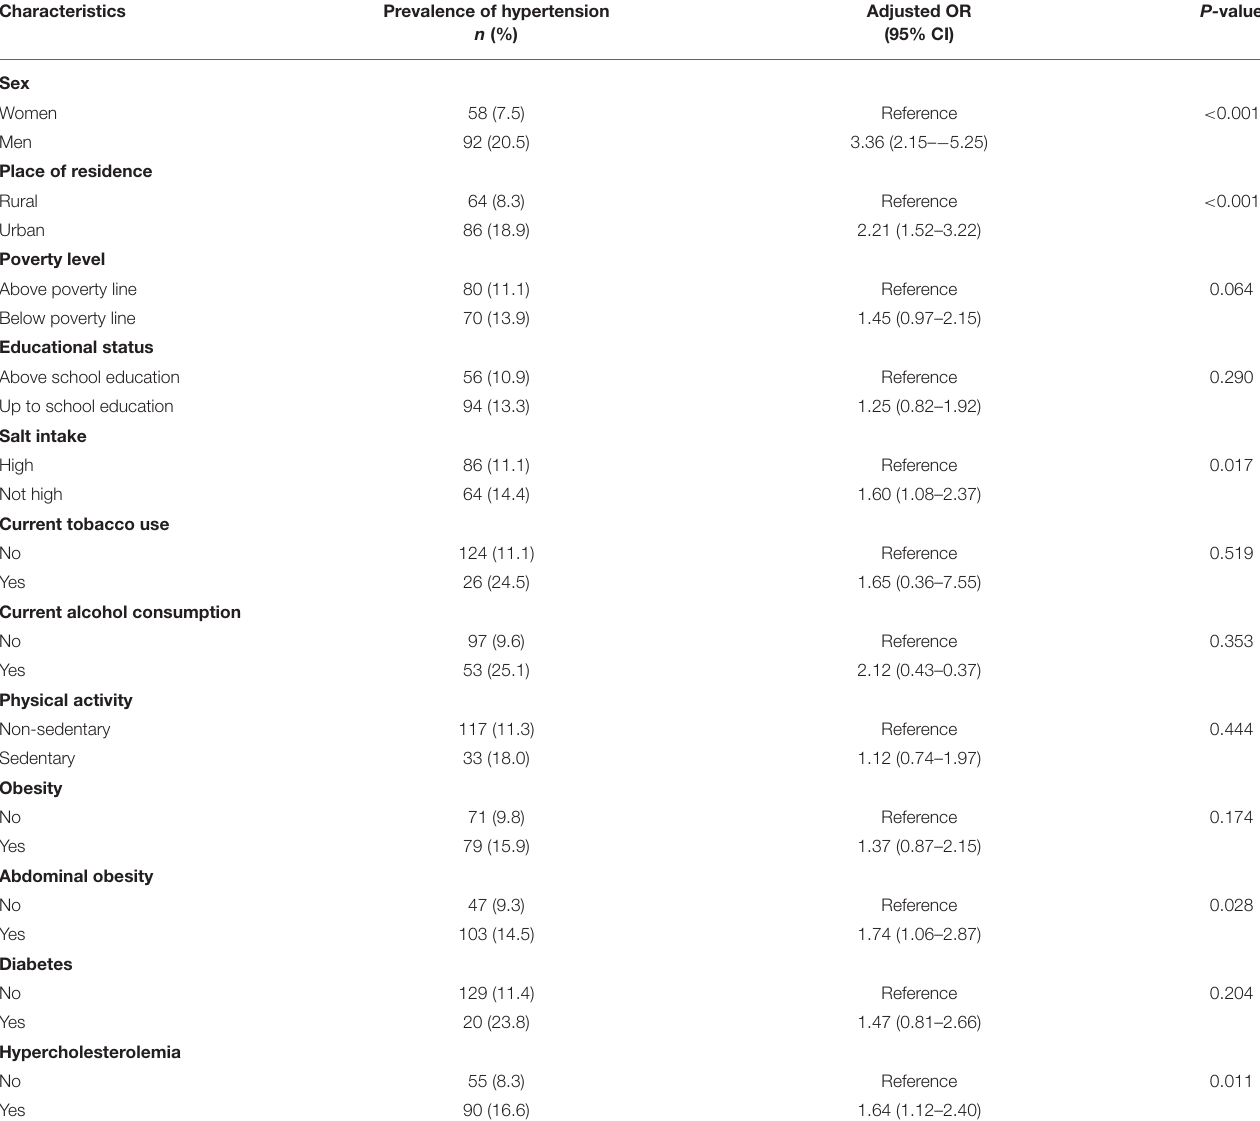
TABLE 3 | Prevalence of hypertension by socio-economic status and clinical risk factors in young adults: results of bivariate and age adjusted multivariate analysis.